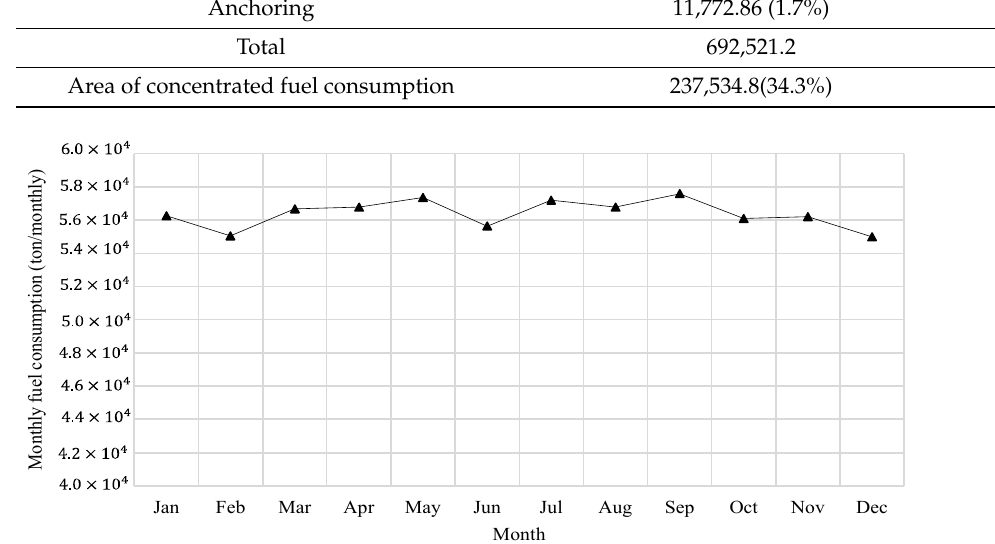
Figure 4. Area of concentrated fuel consumption in BP in 2019.